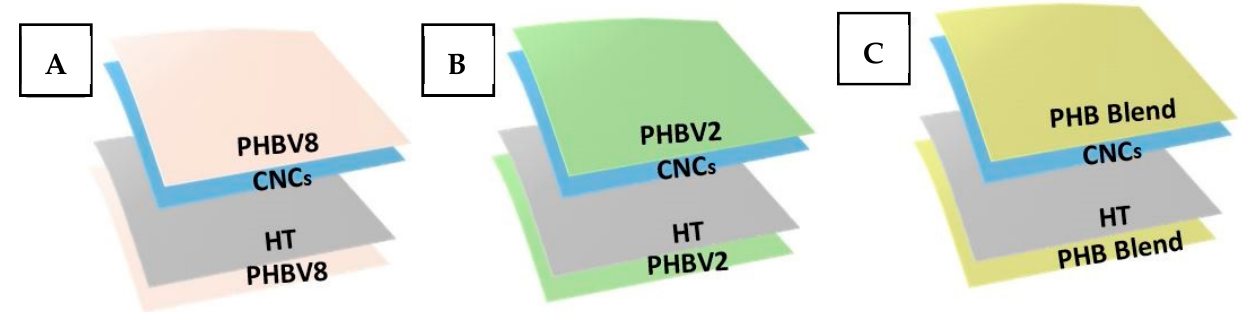
Figure 1. Schematics of the multilayer films of ( A ) poly(3-hydroxybutyrate- co -3-hydroxyvalerate) containing 8 mol.% 3-hydroxyvalerate (PHBV8), ( B ) poly(3-hydroxybutyrate- co -3-hydroxyvalerate) with 2 mol.% 3-hydroxyvalerate (PHBV2), and ( C ) poly(3-hydroxybutyrate) with poly(butylene adipate- co -terephthalate) blend (PHB Blend). The electrospun biowaste- derived poly(3-hydroxybutyrate- co -3-hydroxyvalerate) with 20 mol.% 3-hydroxyvalerate mat was used as a hot-tack (HT) coating on one layer, while the cellulose nanocrystal (CNC) layer was added on the other